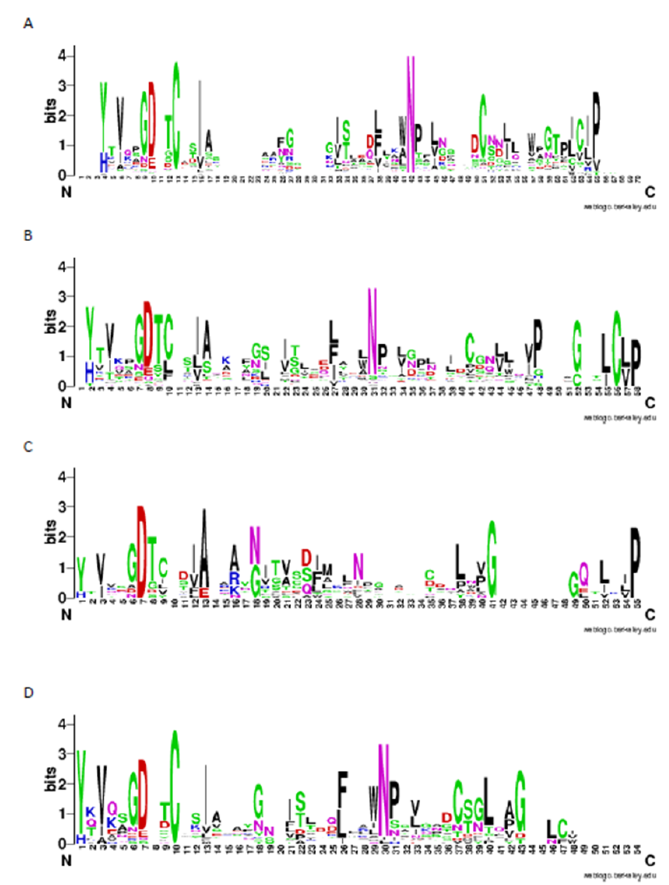
Figure 3. Amino acid conservation of LysM domains. Classification of LysM domains according to their lifestyle using WebLogo. ( A ) Endophytic lifestyle; ( B ) phytopathogenic lifestyle; ( C ) both lifestyles; ( D ) others. Letters correspond to the amino acid code that is used with the International Nucleotide Sequence Database, one letter code.